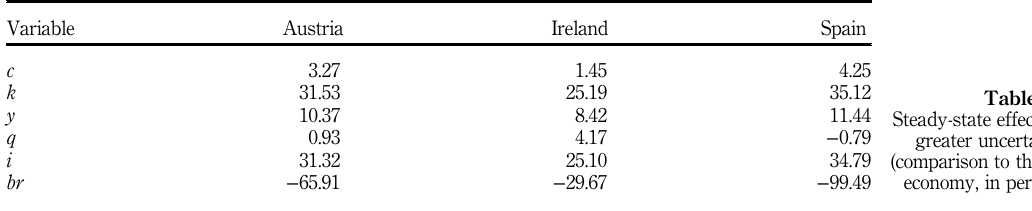
Table IV. Steady-state effects